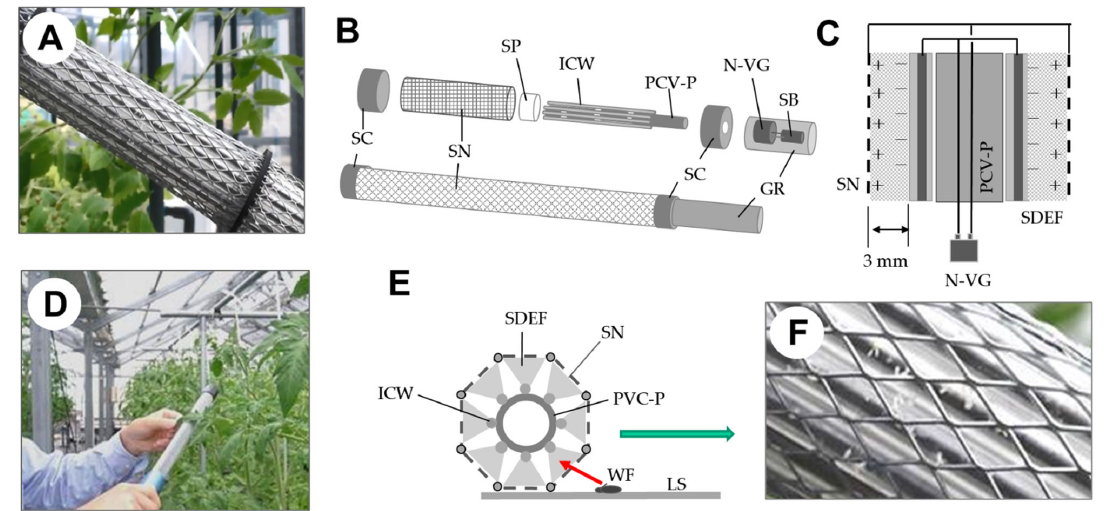
Figure 13. ( A ) Electrostatic insect sweeper (EIS) used to trap insects resting on greenhouse tomato leaves. ( B ) Schematic representation of the EIS structure. ( C ) Schematic representation of the inner EIS structure. ( D ) EIS capturing whiteflies on leaves. ( E ) Schematic representation of insect capture on a leaf (plan view). Red and green arrows indicate the directions of insect attraction and leaf-surface sweeping with the EIS, respectively. ( F ) Whiteflies trapped by the EIS insulated conductor wire. SC, sealing cap; SN, stainless net; SP, spacer; ICW, insulated conductor wire; PVC-P, polyvinylchloride pipe; N-VG, negative voltage generator; SB, storage battery; GR, grip; SDEF, single-charged dipolar electric field; WF, whitefly; LS, leaf surface. [7].